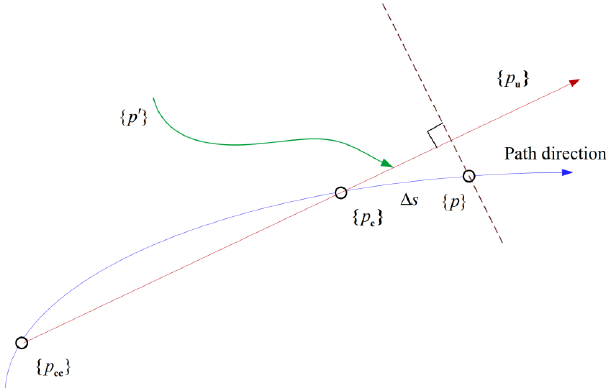
Figure 1. Partial schematic diagram of the balance path based on the arc length extension